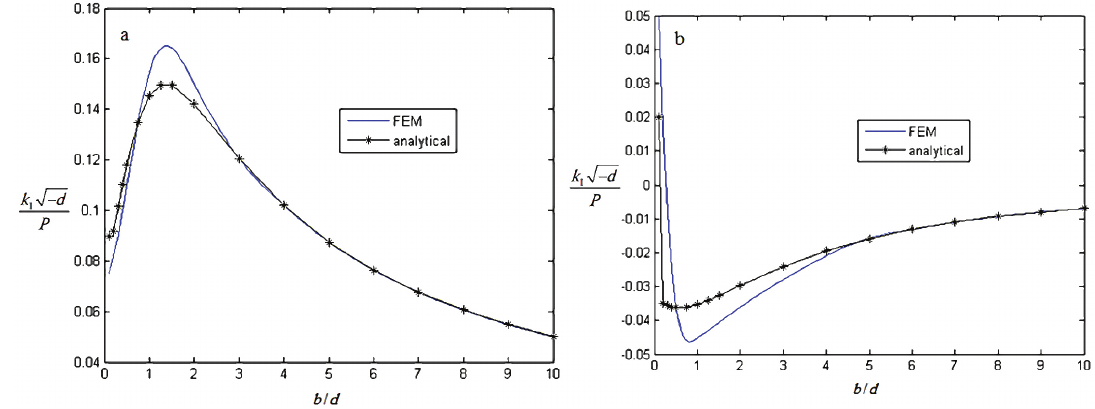
Figure 5. Comparisons of normalized stress intensity factors computed with the analytical model and ABAQUS for the case of a flat punch h =0.8, ν=0.28, (a-b)/d=1: (a) mod І; (b) mod П.